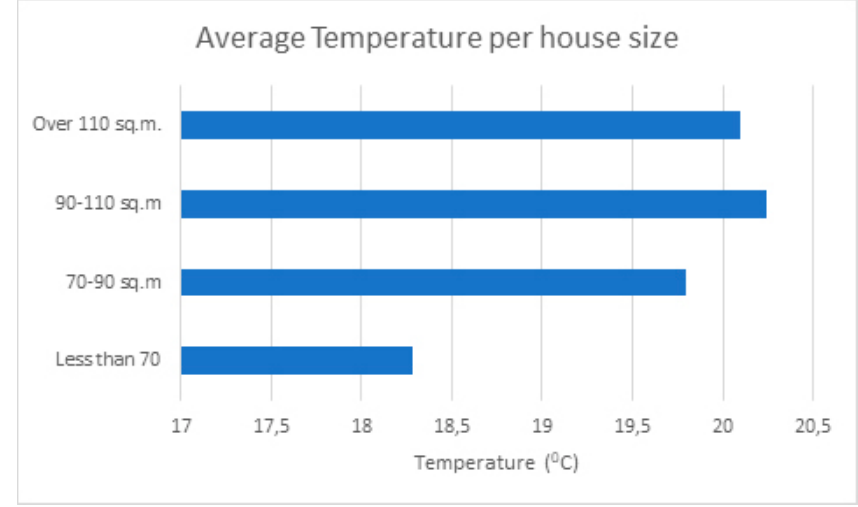
Figure 4. Average indoor temperature related to house size.